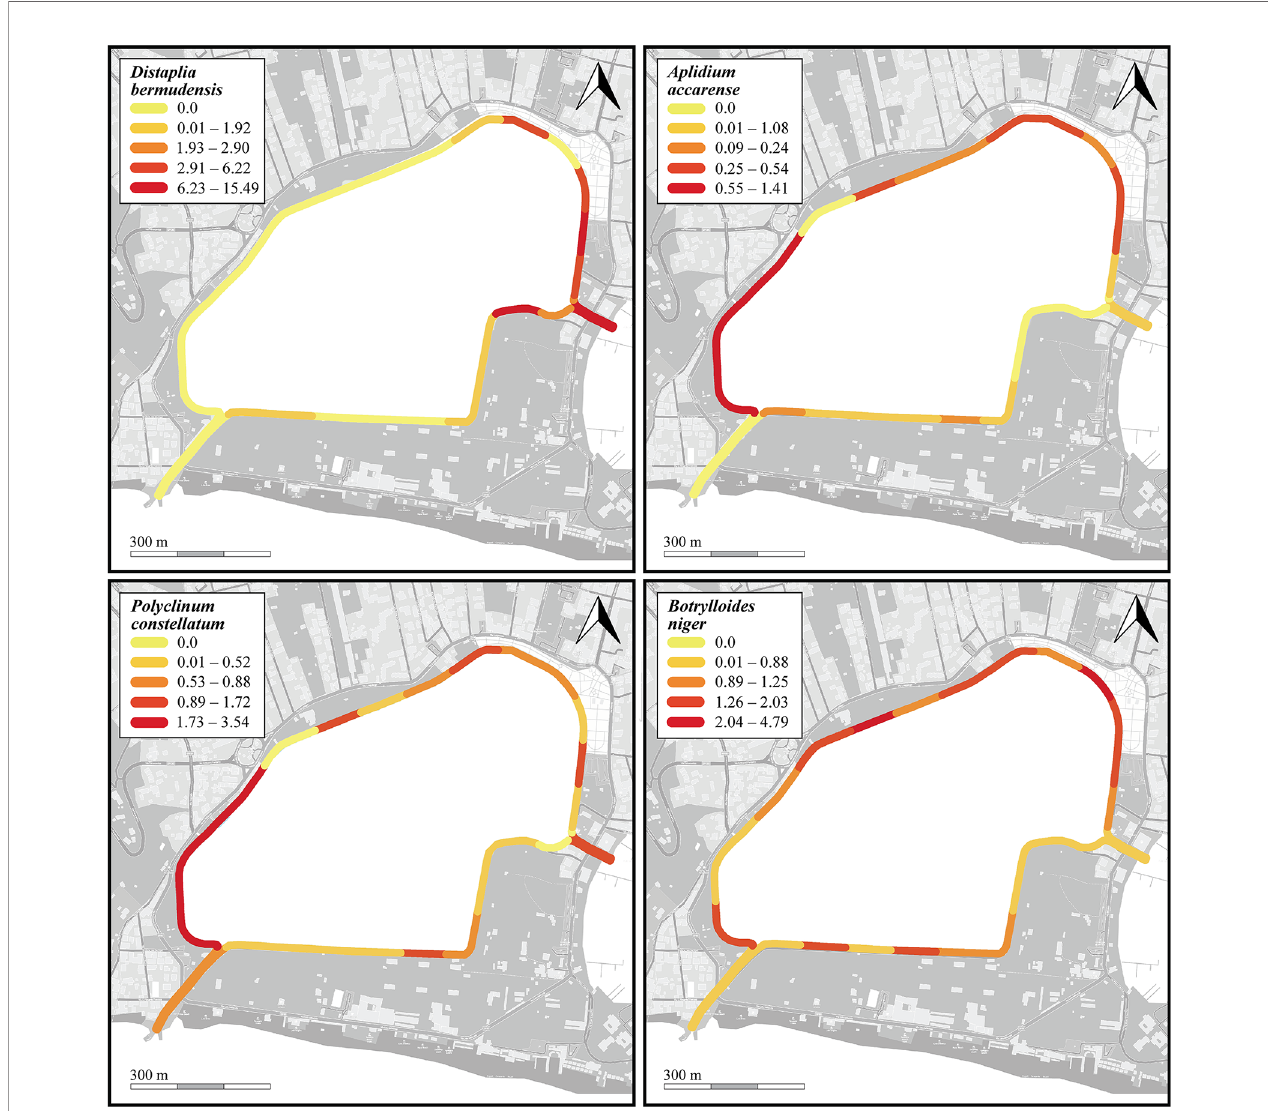
FIGURE 7 | Heatmaps showing percent cover per sector of the four most common NIS ( Distaplia bermudensis , Aplidium accarense , Polyclinum constellatum , and Botrylloides niger ) found on the dock walls of the Miseno Lake. For a detailed account of the sectors see Figure 1